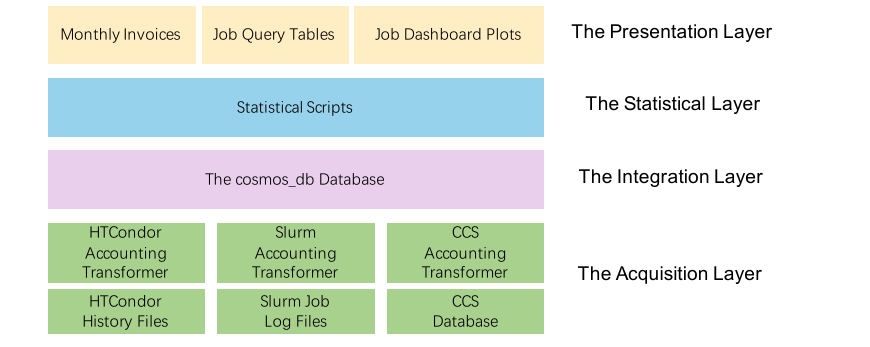
Figure 1: The four-layer system architecture of